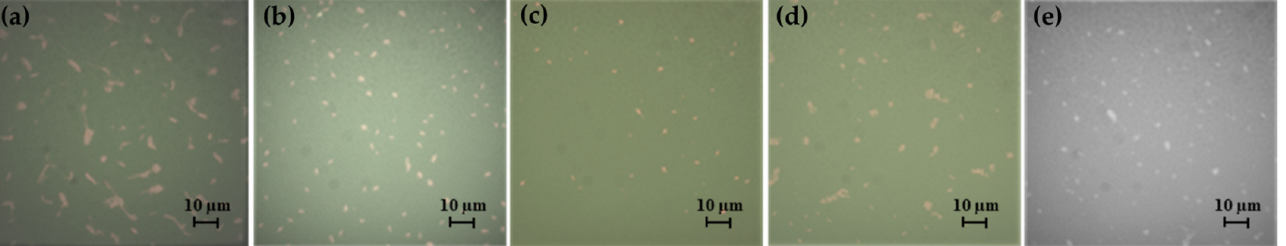
Figure 12. Images of the Gram-negative strain S. maltophilia BC 658 observed with an epifluorescence microscope. ( a ) Control 63×; ( b ) G_A 40×; ( c ) G_A_F3 40×; ( d ) G_A_F16 40×; ( e ) G_A_F3_F16 40×. Figure 13. Images of the spore-positive Gram-positive strain R. aquimaris BC 660 observed under an epifluorescence microscope. ( a ) control 40×; ( b ) G_A 40×; ( c ) G_A_F16 40×. The results obtained with the strain of Navicula sp. are shown in Figure 14. The coating alone G_A increased the adhesion of the diatom with an increase in the number of 154% (seen under LM) and 149% (for EM) than control. A diminishing number of adhering cells (regarding G_A_F3 covered glass slide) was observed (10.8%) with LM,